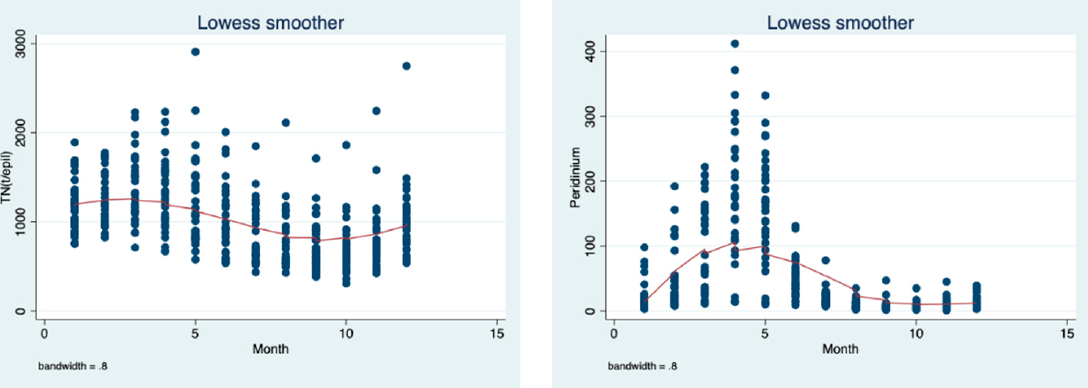
Figure 11. Smoother (0.8 bandwidth) trend of changes of monthly (1–12) means of nitrate ( left ) and ammonium ( right ) concentrations (ppm) averaged for the period from 1968 to 2018 in the epilimnion of Lake Kinneret.